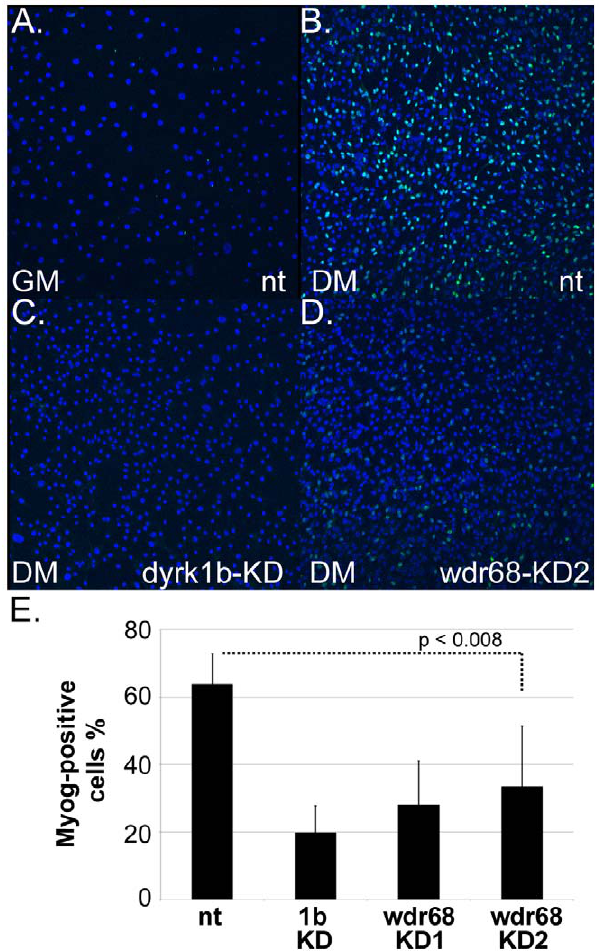
Figure 4. Wdr68 is important for Myog expression in differen- tiating C2C12 cells. A–D) Overlay of DAPI and Alexa-488 detection of Myog expression. A) Non-target (nt) control cells in growth medium (GM). B) nt control cells expressing Myog after 48 hours in differentiation medium (DM). C) Severely reduced expression of Myog in dyrk1b -KD cells. D) Reduced expression of Myog in wdr68 -KD2 cells. E) Graph summarizing the number of Myog + cells results for eight independent